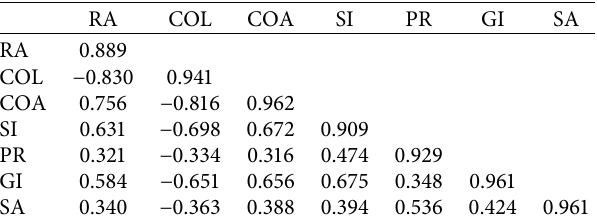
Table 6: Results for discriminant validity (Fornell-Larcker criterion).